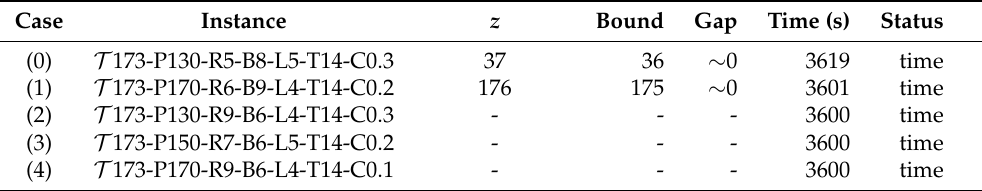
Table 5. Gurobi results for unsolved problem instances.